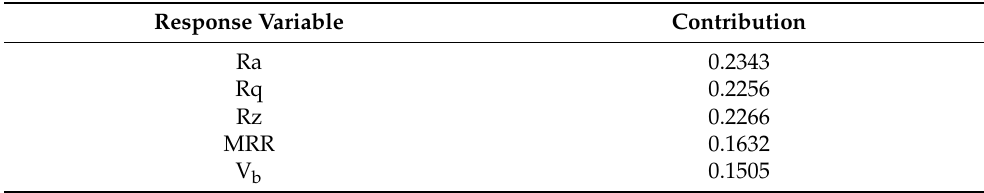
Table 9. Variance contribution of quality responses for PC 1.